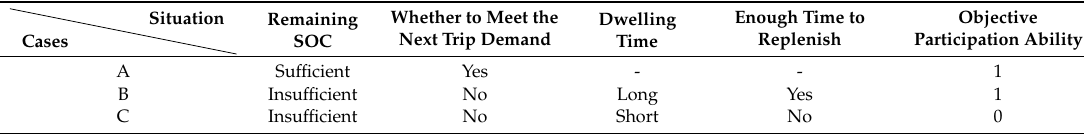
Table 2. Objective participation ability of EVs under di ff erent